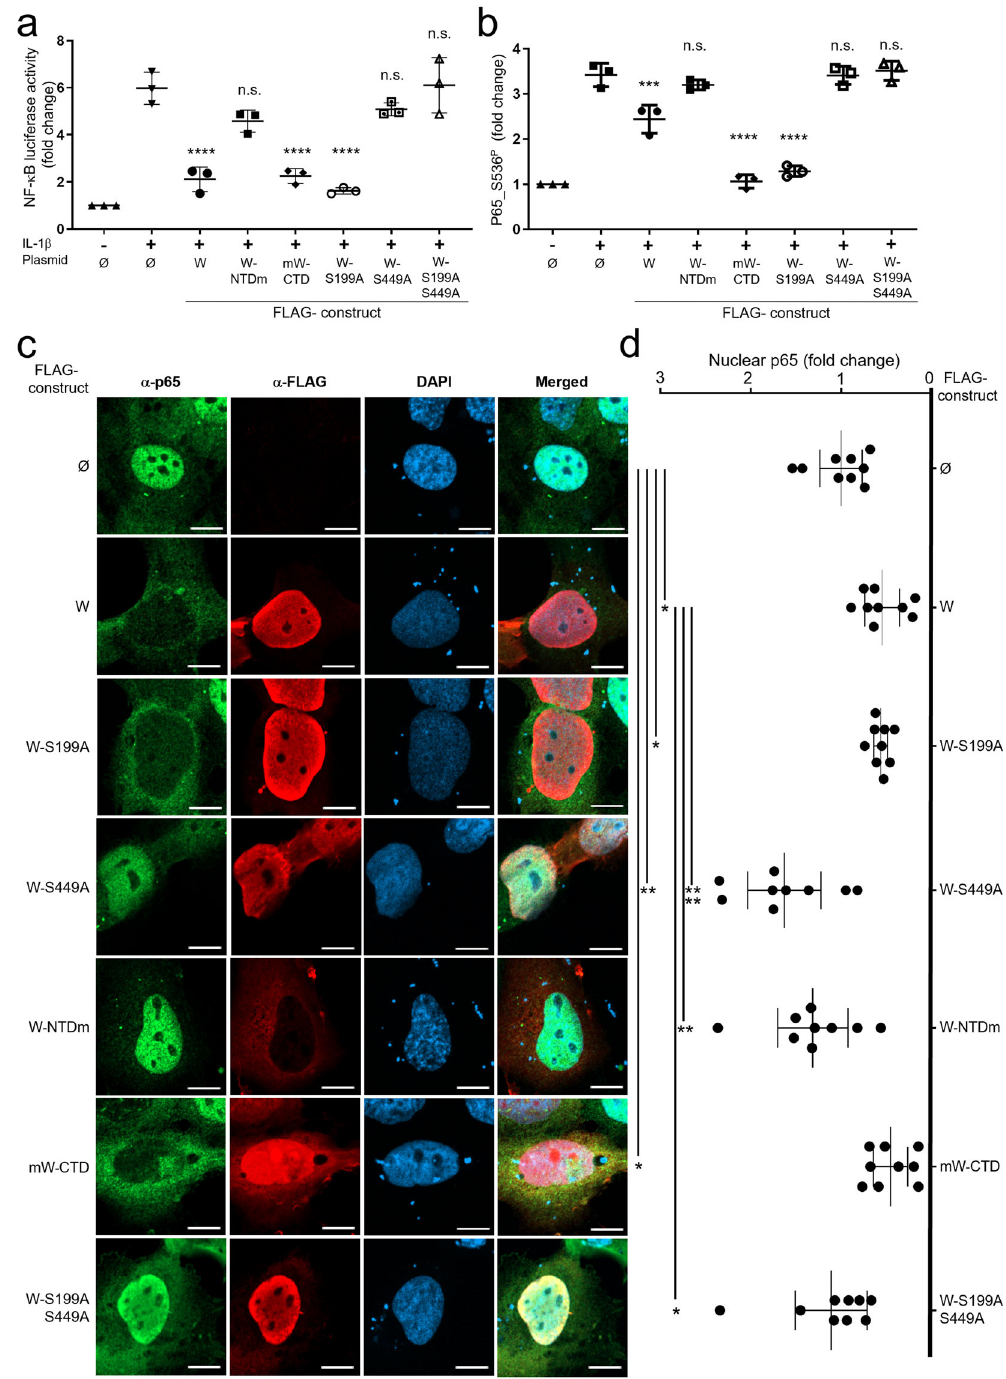
Fig. 4 W-S449 is required for the inhibition of the canonical NF- κ B pathway, and the phosphorylation and nuclear accumulation of NF- κ B p65. a HPMECs were cotransfected with a NF- κ B_luc plasmid and a plasmid expressing the indicated FLAG-tagged W protein. Transfection with Renilla luciferase was used for the normalization of obtained results. Twenty hours after transfection, cells were stimulated with 10ng/mL of IL-1 β for 20min and NF- κ B activity was assessed by luminescence quanti fi cation. The data represent mean values of three independent experiments showed as mean±SD ” . b , HPMECs were transfected with the indicated plasmids. Forty-eight hours after transfection, cells were stimulated with 10ng/mL of IL-1 β for 20min, and p65 and phosphorylated p65 at Ser536 (p65_Ser536 P ) were evaluated by western blotting. Data columns represent the mean±SD of densitometry measurements done on samples from three independent experiments using ImageJ software. c HPMECs were transfected with the indicated plasmids and stimulated with 10ng/mL of IL-1 β for 20min. After fi xation and staining with NF- κ B p65 and anti-FLAG antibodies, cells were analyzed by confocal microscopy (scale bar = 10 µ m). d Mean fl uorescence intensity of nuclear p65 protein. The nuclear signal obtained from anti-FLAG labeled cells was normalized to the nuclear signal from unlabeled cells and expressed as fold change. Error bars represent the con fi dence interval of the mean (CI 95%) for nine cells combined from three independent experiments. Statistical signi fi cance was assessed by one-way unpaired ANOVA completed with a multiple-comparisons Tukey ’ s test; only signi fi cant comparisons are shown (* p <0.05, ** p <0.01, *** p <0.001, **** p <0.0001). COMMUNICATIONS BIOLOGY| (2021) 4:1292 |https://doi.org/10.1038/s42003-021-02797-5|www.nature.com/commsbio